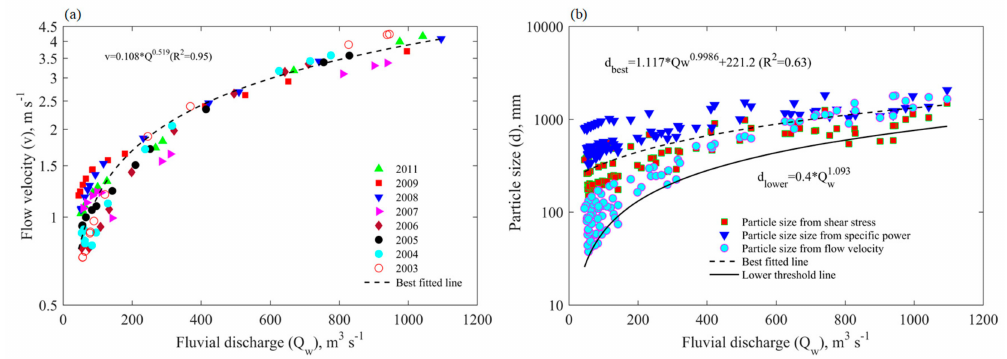
Figure 4. Relationship of the fluvial discharge, ( a ) flow velocity, and ( b ) particle size (boulder).